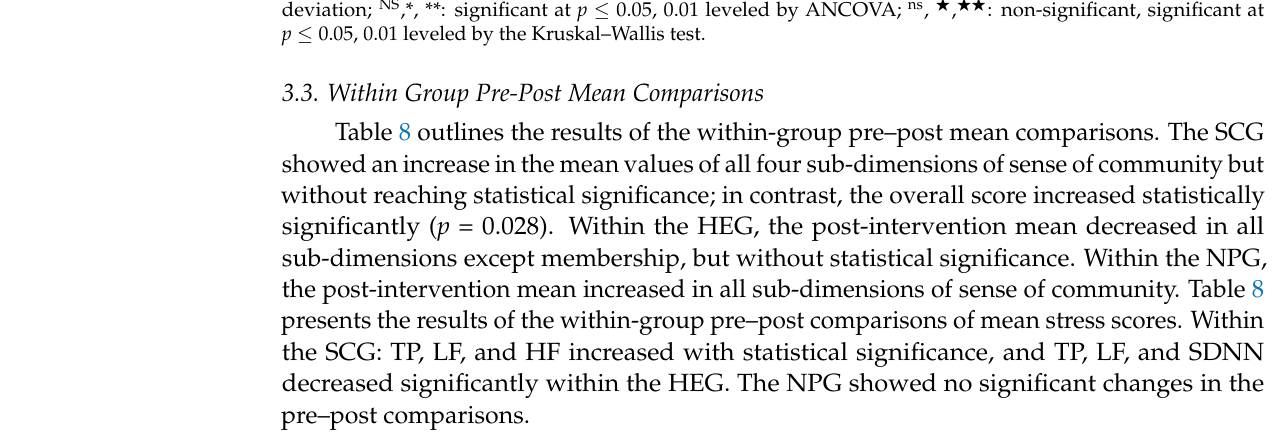
Table 8. Comparison of within-group pre–post means for sense of community and